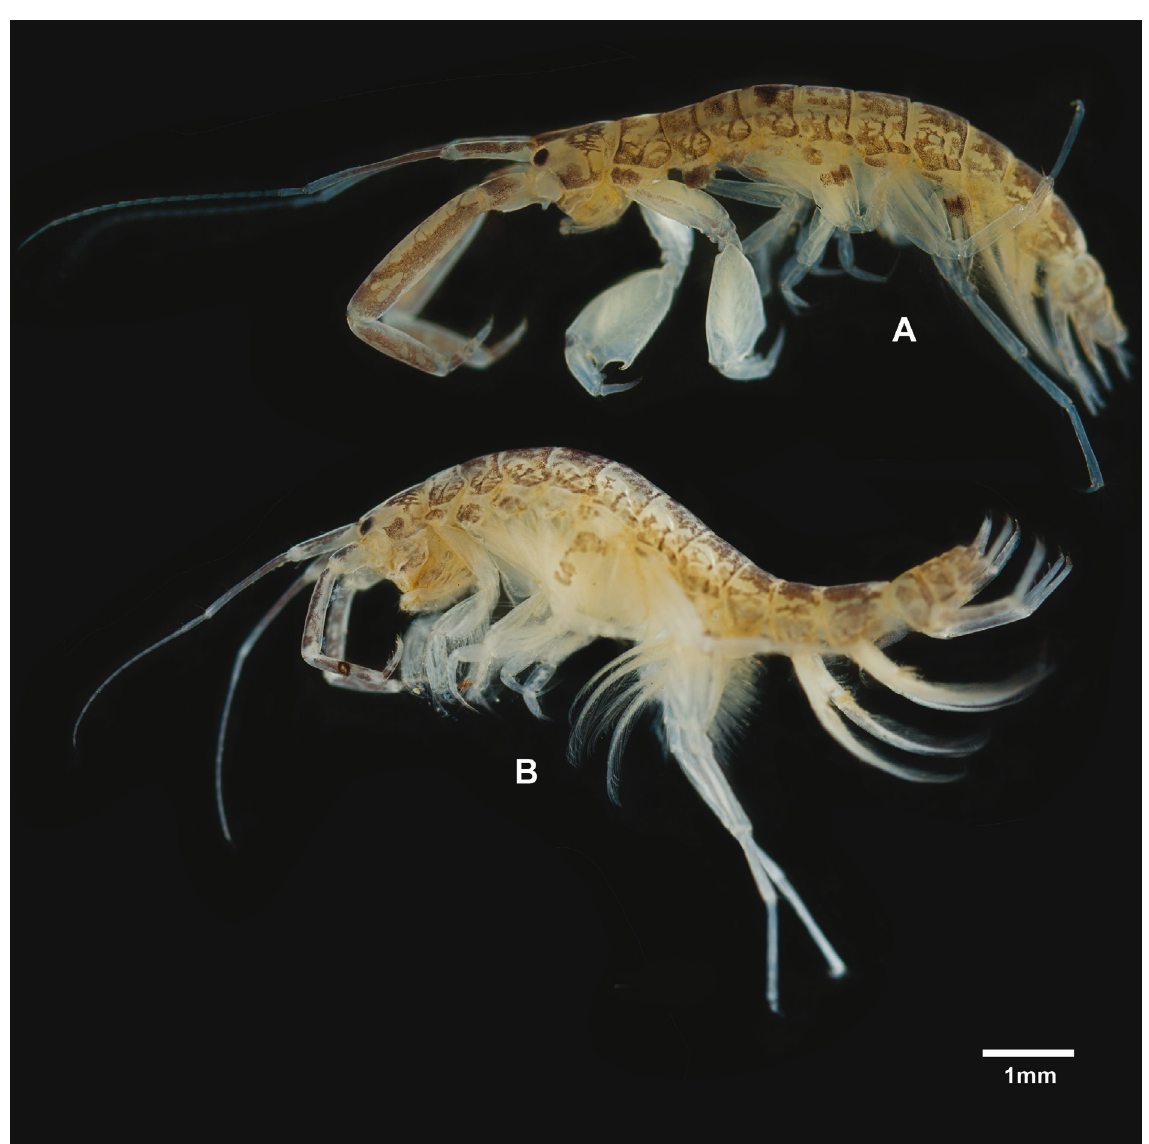
Fig. 11. Grandidierella sungeicina sp. nov. A . Holotype, ♂, lateral view (ZRC 2018.0490). B . Allotype, ♀, lateral view (ZRC